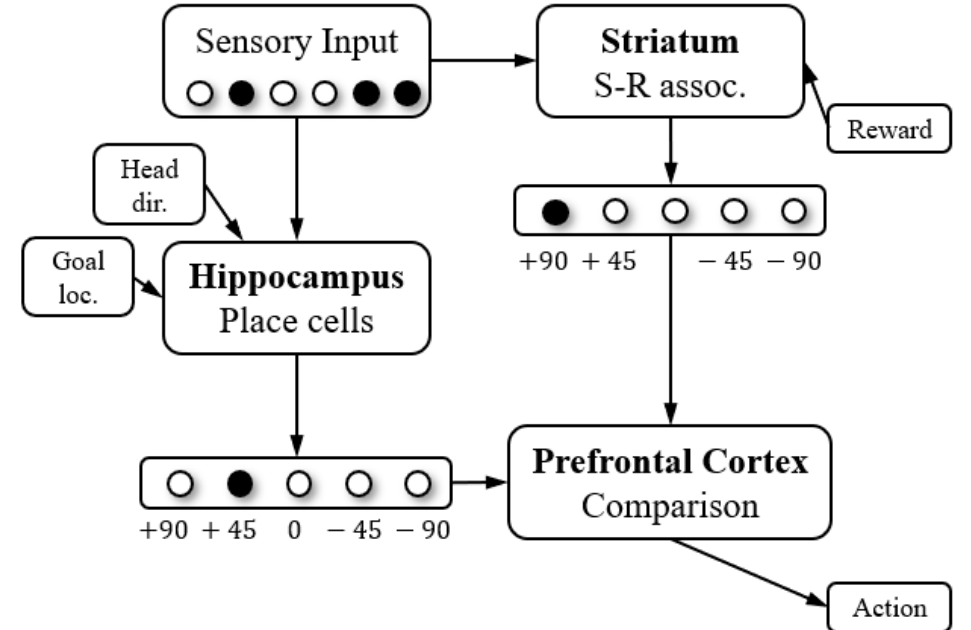
Figure 1. A minimal cognitive architecture for spatial navigation proposed by Chersi et al. [29]. The figure presents a schematic representation of the hippocampal–striatal circuit that guides spatial navigation. The hippocampus and striatum use the same sensory input and output the estimated optimal actions, which are arbitrated and chosen by the prefrontal cortex.